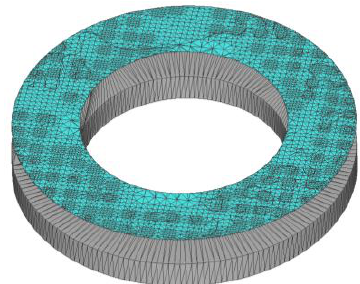
Figure 15. A solid model (bottom) and generated mesh (top) using Screened Poisson Surface Reconstruction technique.